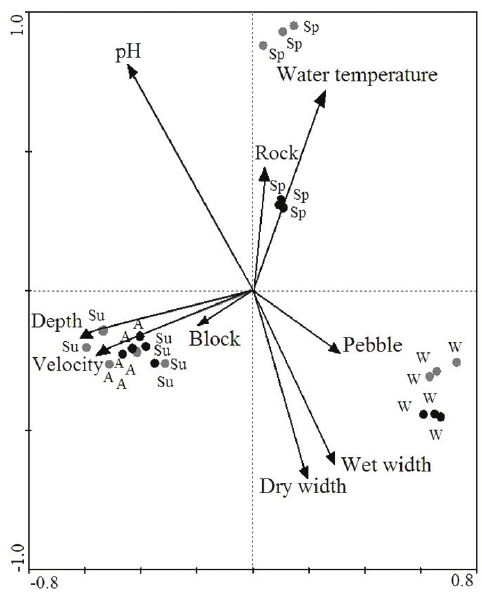
Figure 7. CCA ordination of drift samples and abiotic variables in Achiras stream. Habitats: run ( ) and riffle ( ). Seasons: autumn (A), winter (W), spring (Sp) and summer (Su).